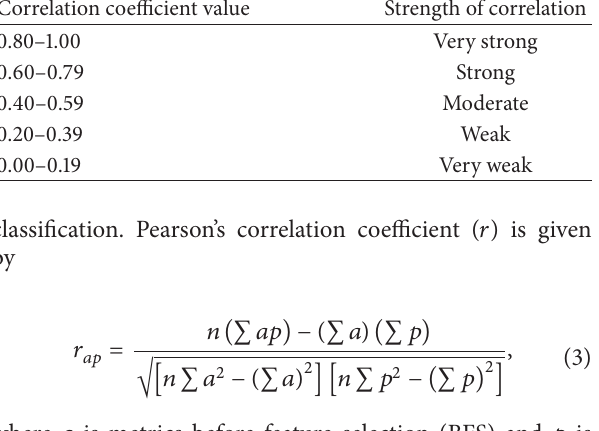
Figure 10: Exact match-J48. Table 7: Correlation between BFS and MFSS for four